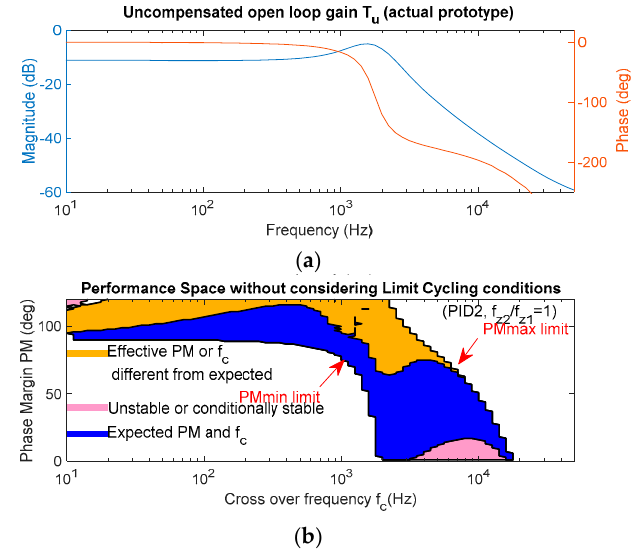
Figure 12. ( a ) The actual prototype’s uncompensated open loop gain; ( b ) performance space without considering limit cycling conditions.